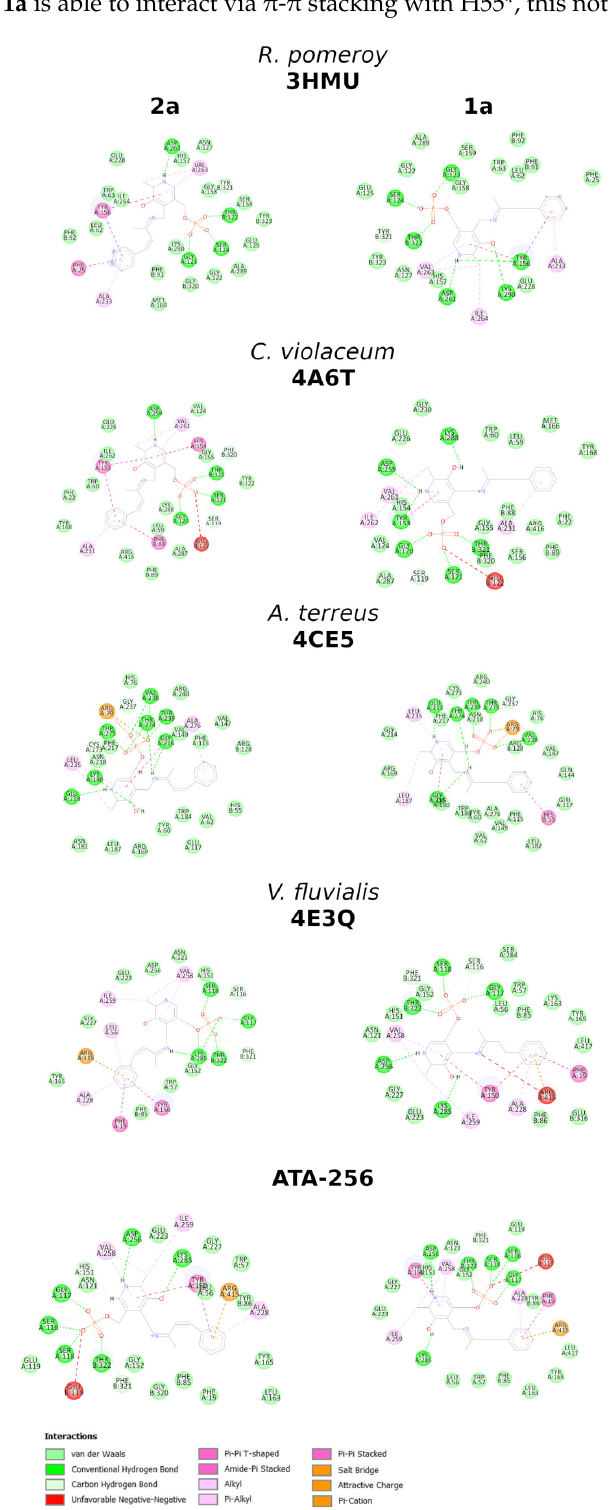
Figure 3. Analysis of the interactions obtained by the molecular docking of 2a and 1a .